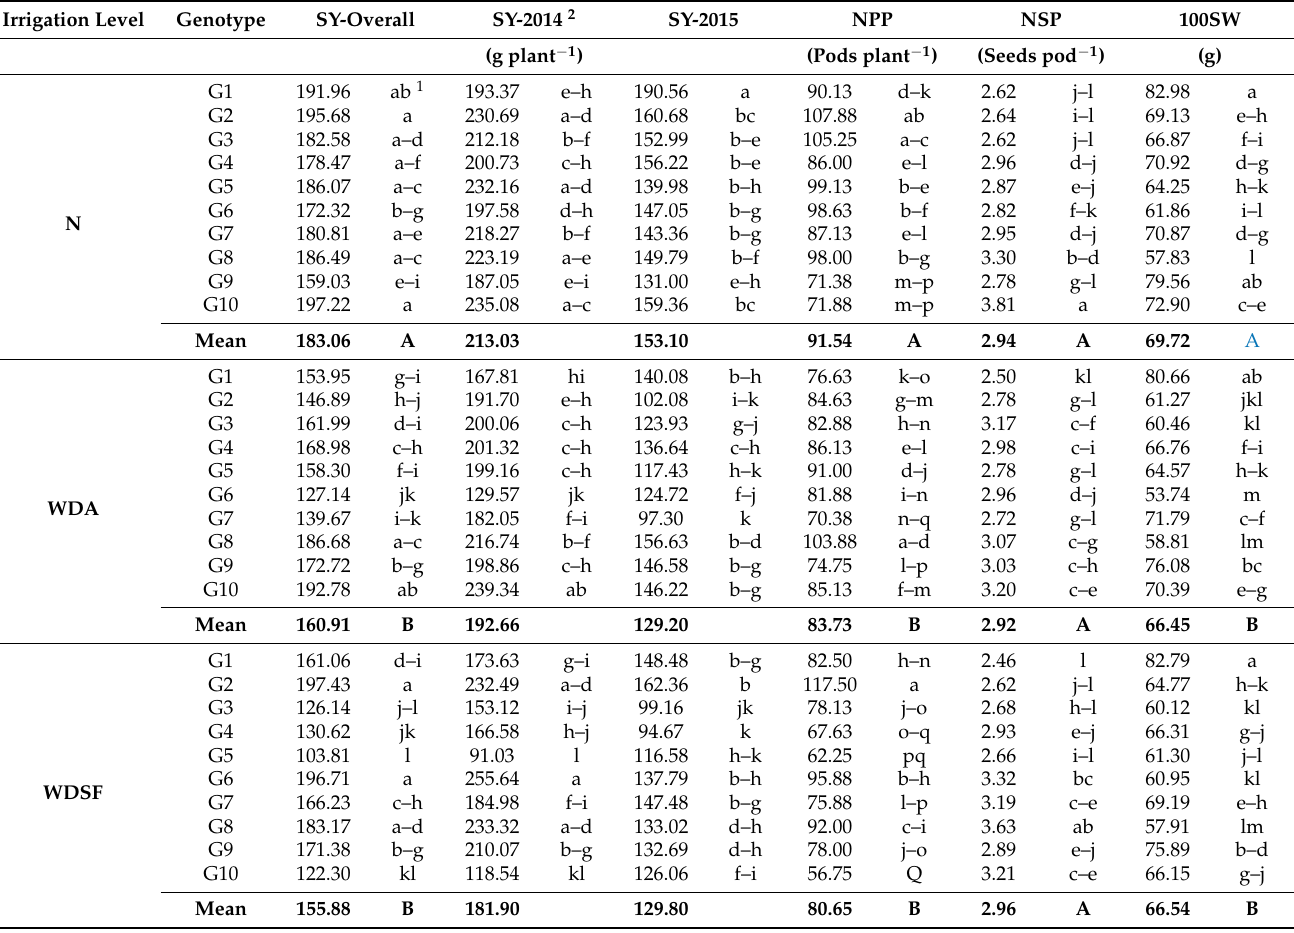
Table 2. Comparisons for seed yield and yield components of the ten bean genotypes as affected by three irrigation levels (N, normal irrigation, WDA, water stress during anthesis; WDSF, water stress during seed filling stage) for two years